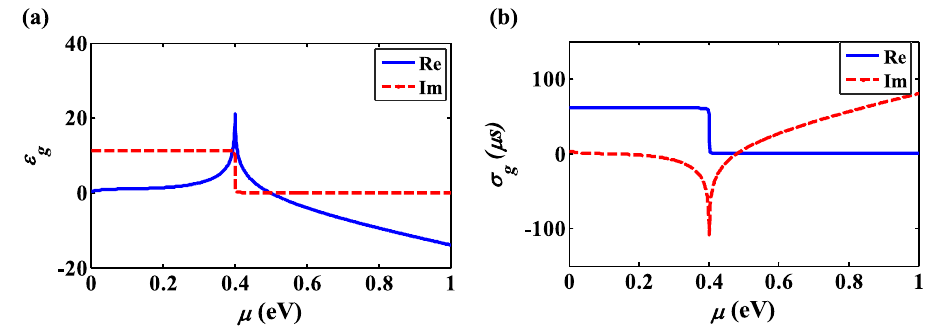
Figure 7. ( a ) Dielectric permittivity and ( b ) conductivity of graphene as a function of chemical potential at 1550 nm.